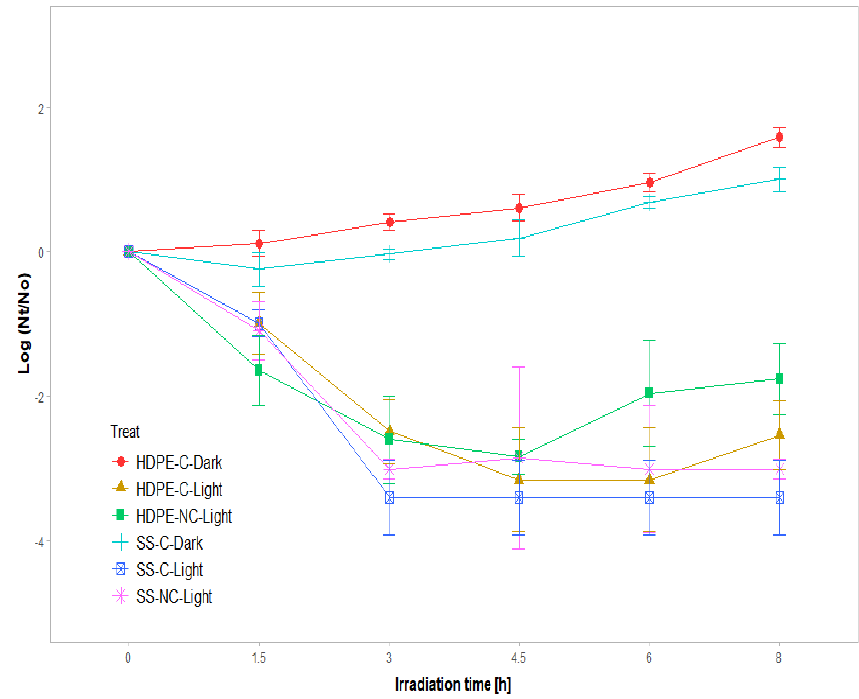
Figure 6. Degradation of E. coli solution by P25 TiO 2 -coated materials (HDPE-C-Light,